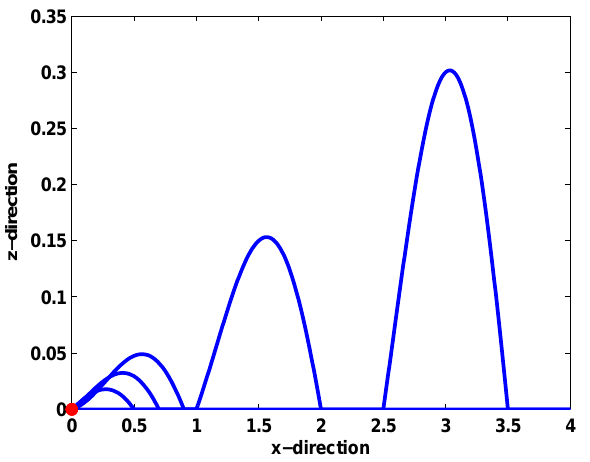
Fig. 3. Evolution of the shock structure in the first quadrant. For U = 0 the shape of the shock is plotted for t = 0 . 5, t = 0 . 7, t = 0 . 9, t = 2, t = 3 . 5 (from left to right).